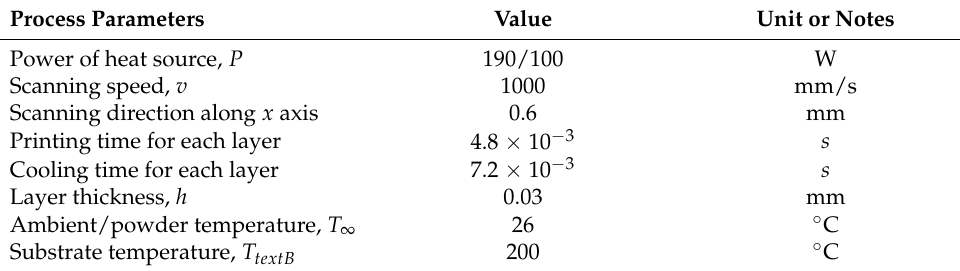
Table 1. Process parameters for the simulation of SLM